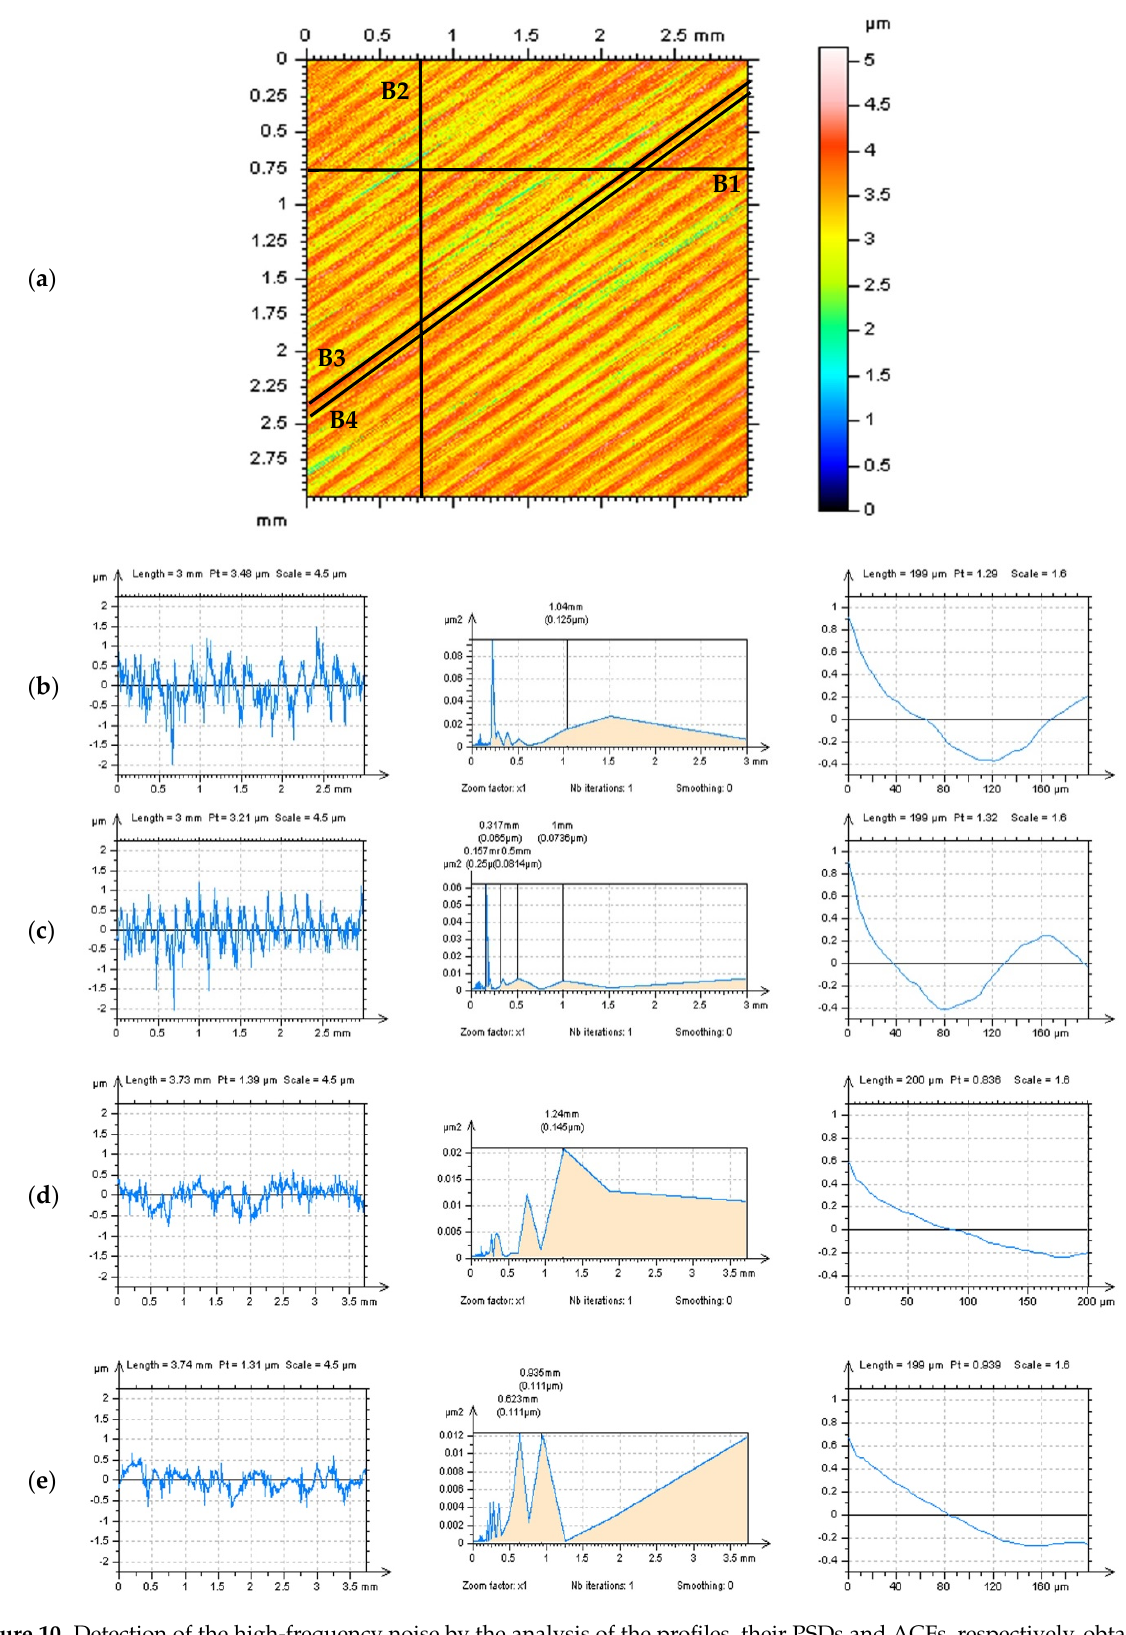
Figure 10. Detection of the high-frequency noise by the analysis of the profiles, their PSDs and ACFs, respectively, obtained from a milled surface with the extraction of profiles proposed in different directions ( a ): B1 ( b ), B2 ( c ), B3 ( d ), and B4 ( e ).